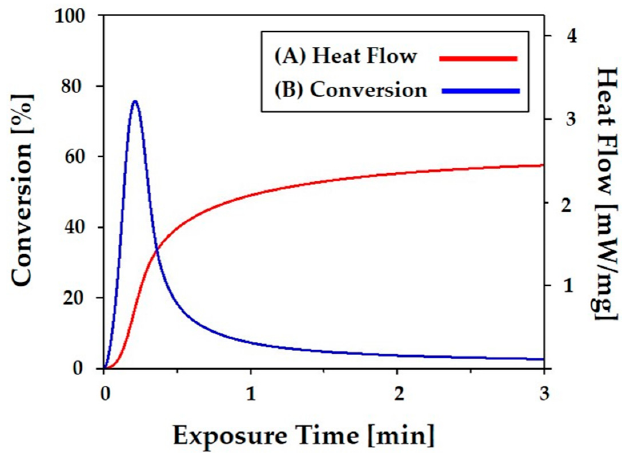
Figure 5. Photo differential scanning calorimetry (photo-DSC) results for the highly concentrated CaP slurry showing ( A ) heat flow and ( B ) % conversion as a function of exposure time.